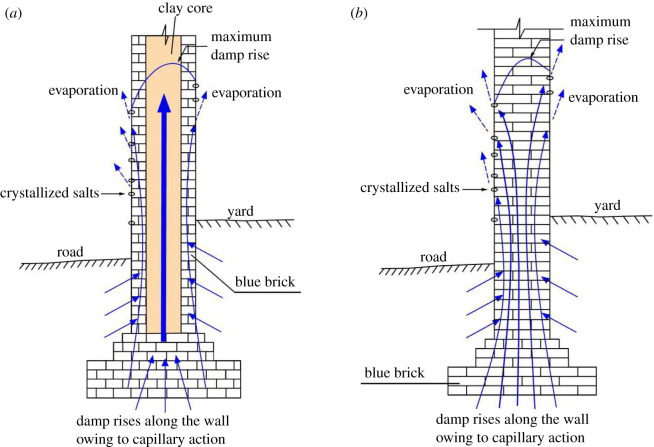
Schematic of the rising damp and salt crystallization in two types of ancient brick walls in the ancient city of Ping Yao. The walls containing clay cores (a) allow for easier transport of damp, and the zone of rising damp will often be higher compared with those of walls without clay cores (b).